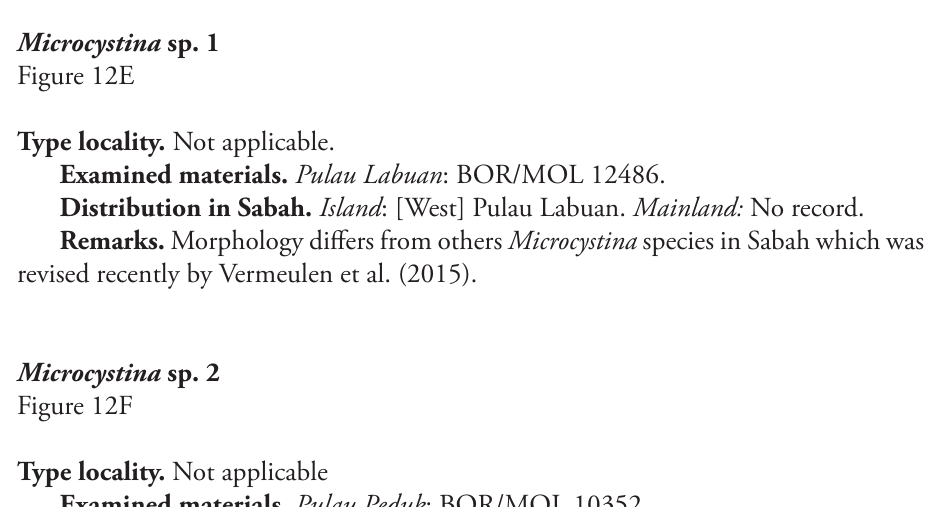
Type locality. Not applicable Examined materials. Pulau Peduk : BOR/MOL 10352.